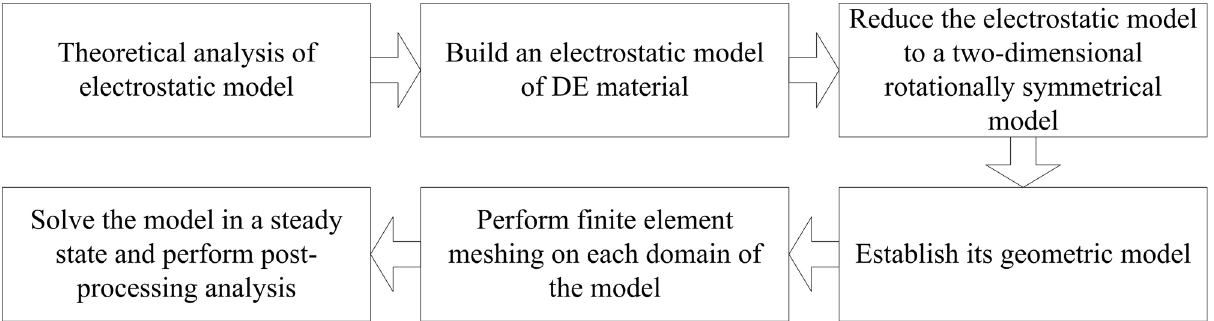
Figure 2. Flow chart for numerical simulation process of DEG electrostatic model based on finite